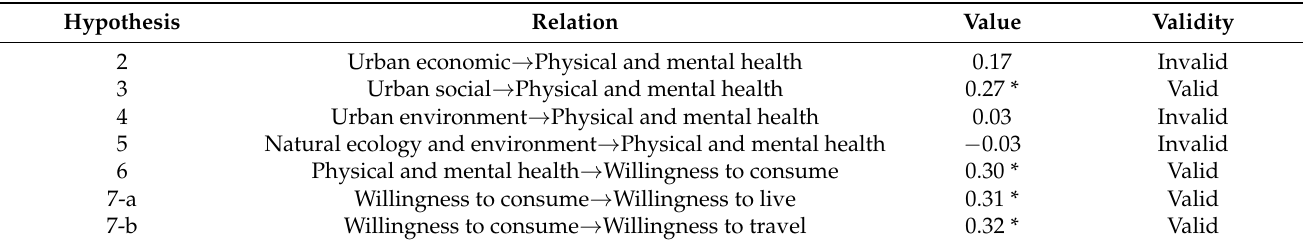
Table 7. Empirical results of research